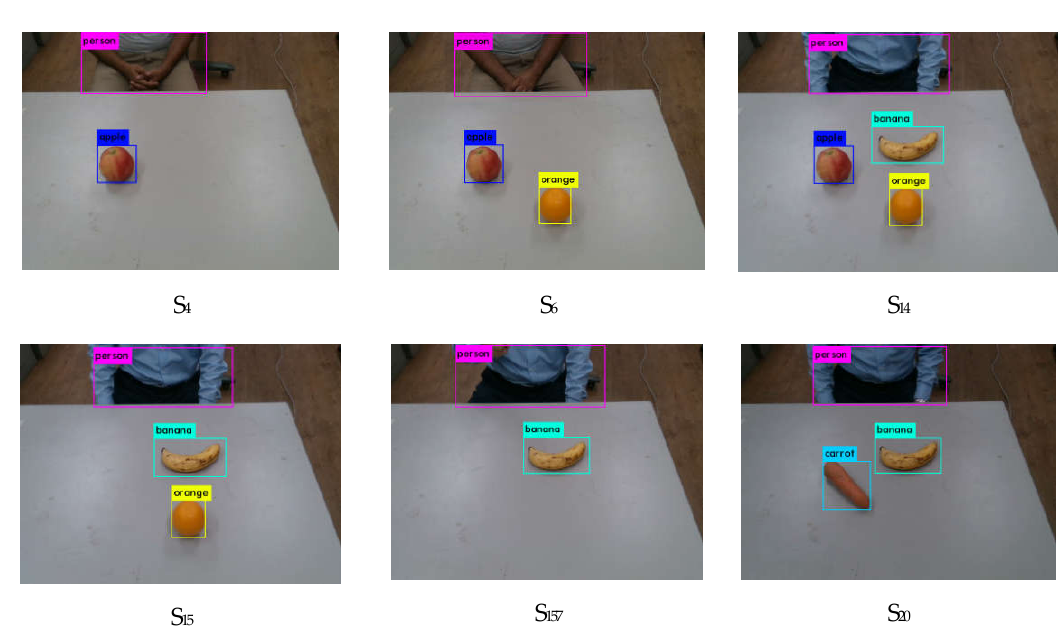
0 Figure 7. The variation of emotional intensity over time applying the parameters of the targets. In the case of LH_O, the intensity of emotional valance is 1 all of the time, which means a priori va- lence of the emotion to the fruits. The parameters for the emotion of LH_A has a long duration of the intensity and sustains the emotion with higher intensity than GA_A and JD_E. The intensity of HF_E has a short duration and long sustain with high values because the emotions of hope and